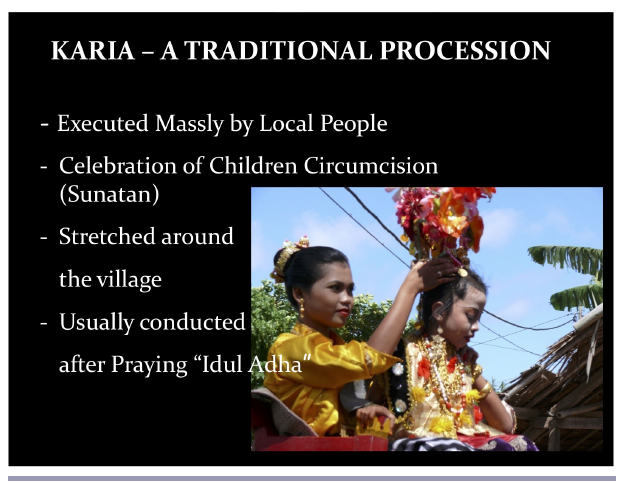
Fig. 2 . A slide showing cultural tourism